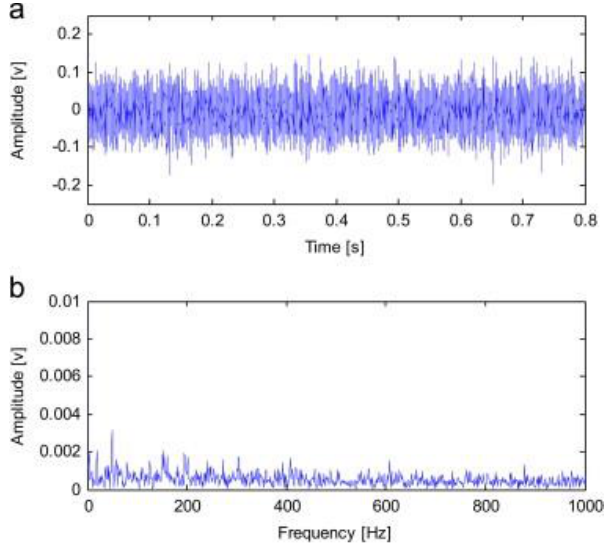
Figure 17. Rolling bearing early weak fault signal: ( a ) Time-domain waveforms; ( b ) Envelope demodulation spectrum [68].